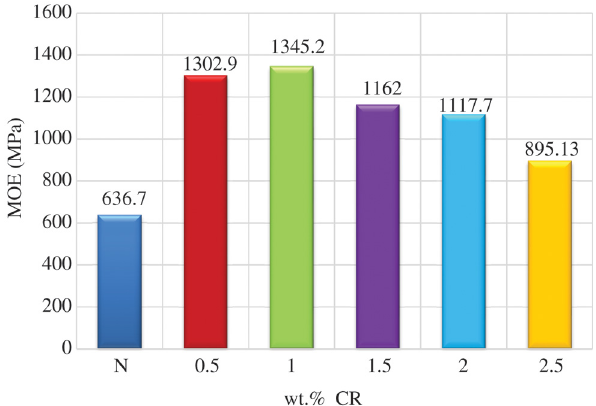
Figure 18: Variation of % elongation with CFR composition.